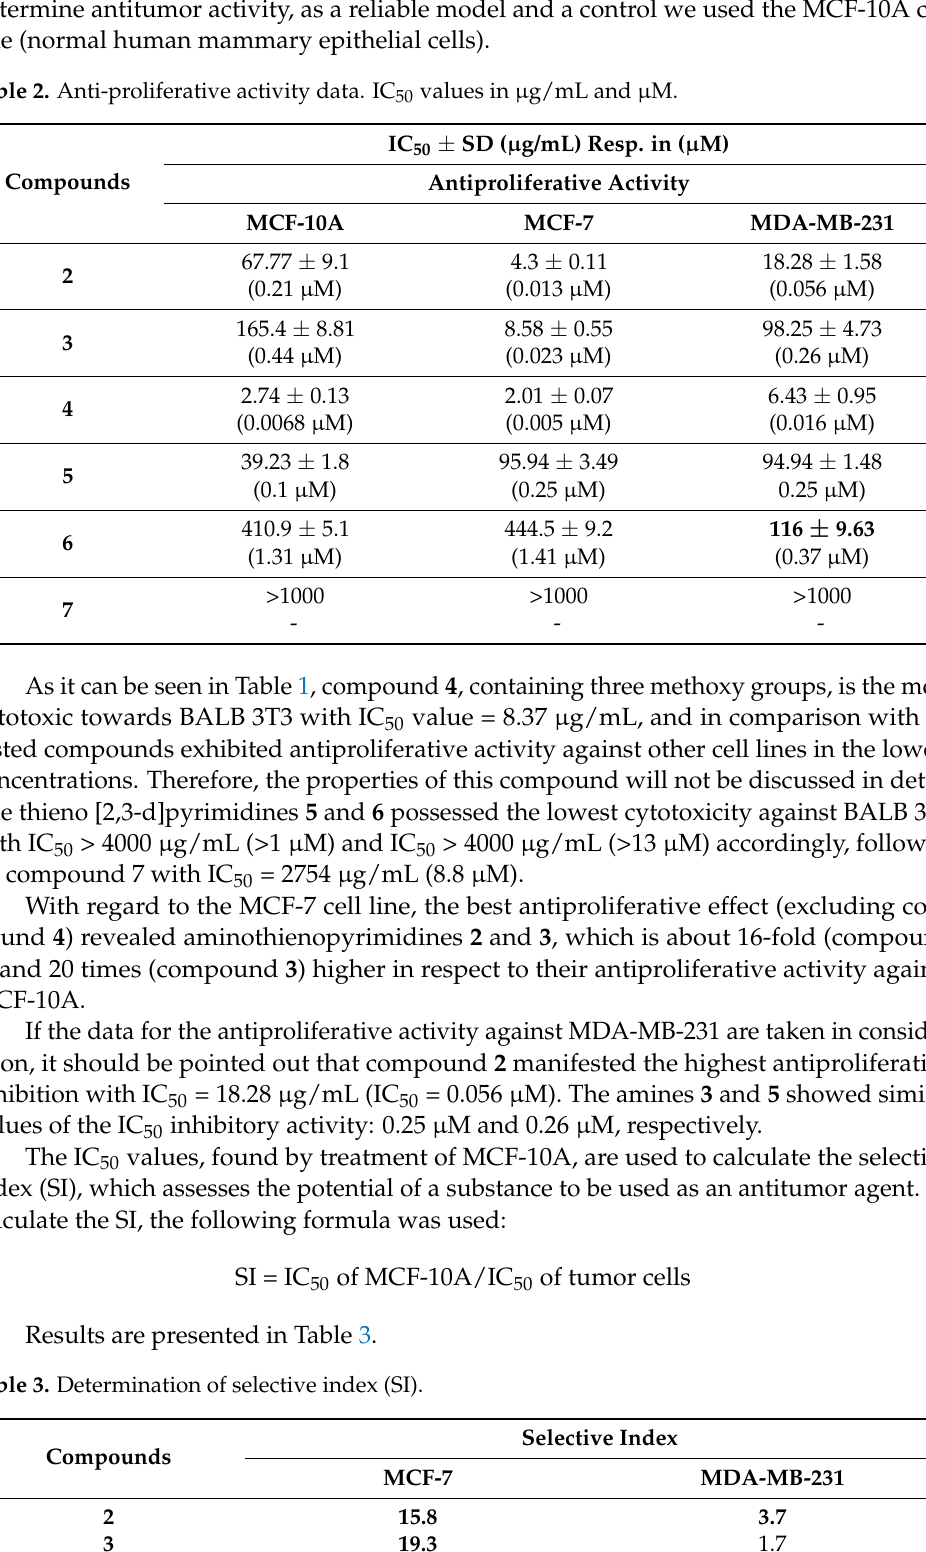
Table 2. Anti-proliferative activity data. IC 50 values in µ g/mL and µ M.